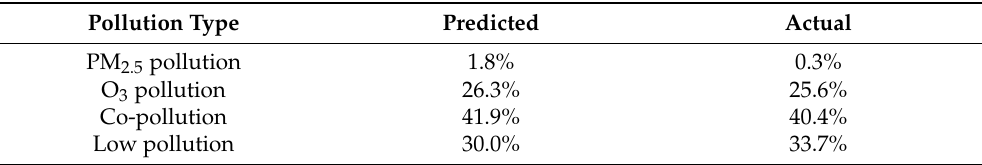
Figure 11. Pollution types and regional trends in the YRD from 2017 to 2020. The main figure shows the combined pollution situation in the YRD region in 2020 predicted using the method in Section 2.3.2. The upper-right inset shows an empirical image of PM 2.5 and O 3 pollution types in 2020. The bands in the legend indicate the regional trends from weak to strong. Table 3. Proportions of basic pollution types in 2020 predicted by the proposed method (“predicted”) and estimated by remote sensing